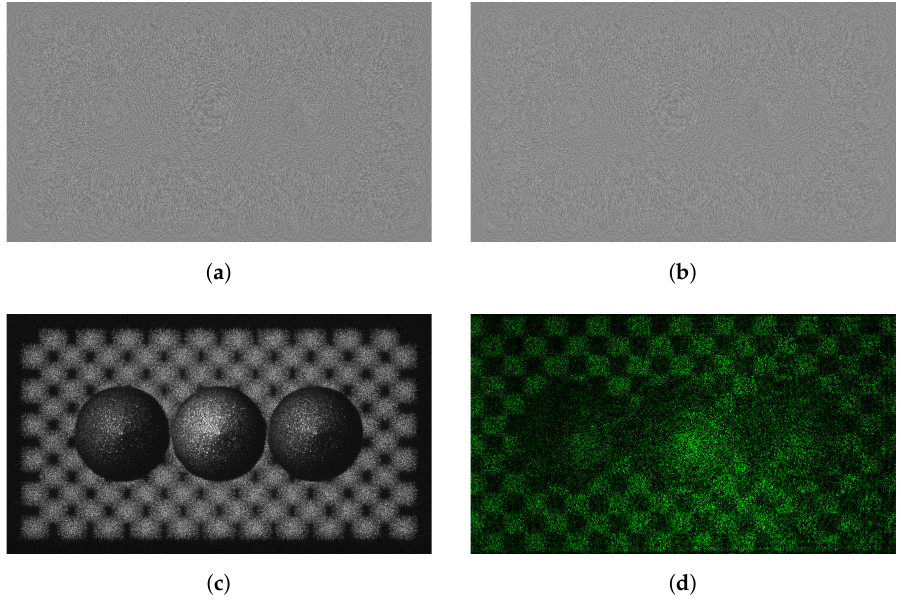
Figure 10. Visual result of the hologram which is watermarked in the real part ( a ) original and ( b ) watermark embedded hologram, ( c ) numerical and ( d ) optical reconstruction result (hologram : 37.829 dB, phase : 26.983 dB, reconstruction : 34.563 dB).